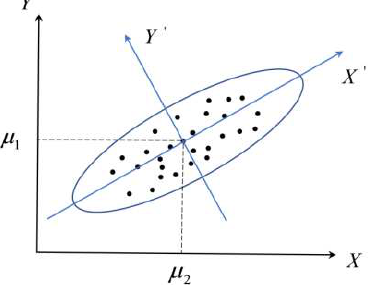
Figure 1. Schematic diagram of the PCA method.